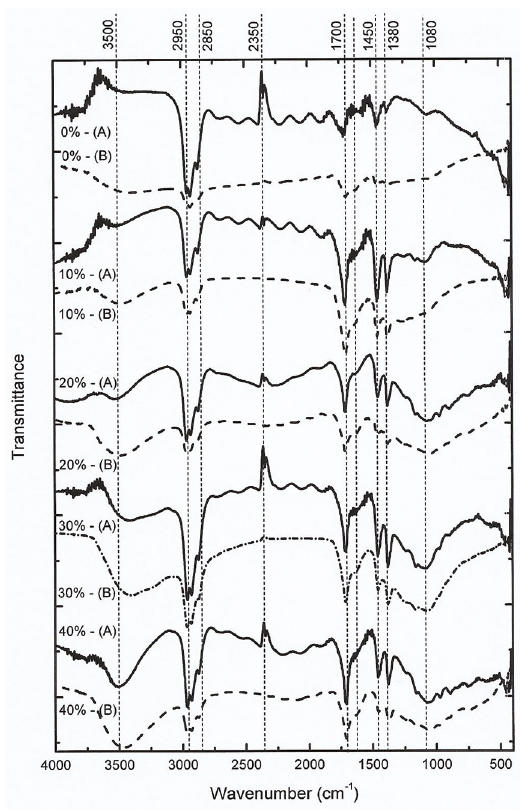
Figure 4: Transmission infrared spectra in the 400 to 4000 cm -1 range of pairs of films, (A) as-deposited, (B) aged, as a function of C